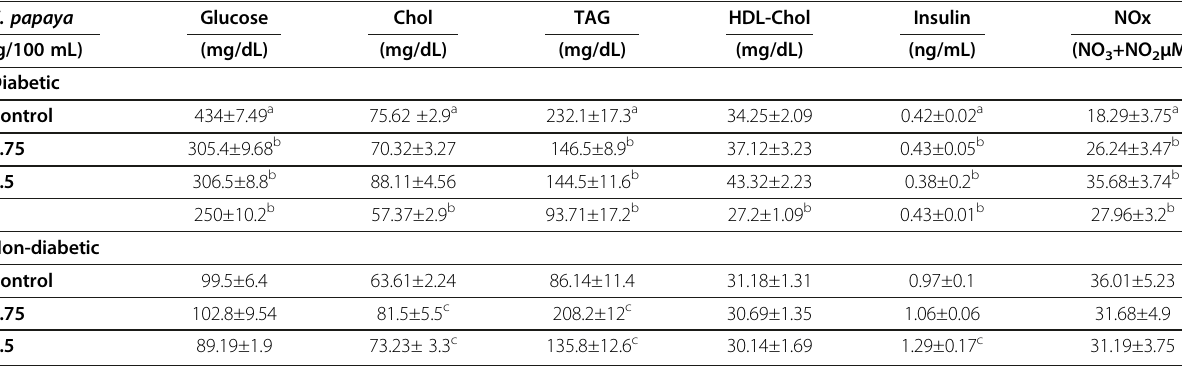
Table 2 Effect of aqueous extract of C. papaya leaf on biochemical parameters in diabetic and non-diabetic rats C.